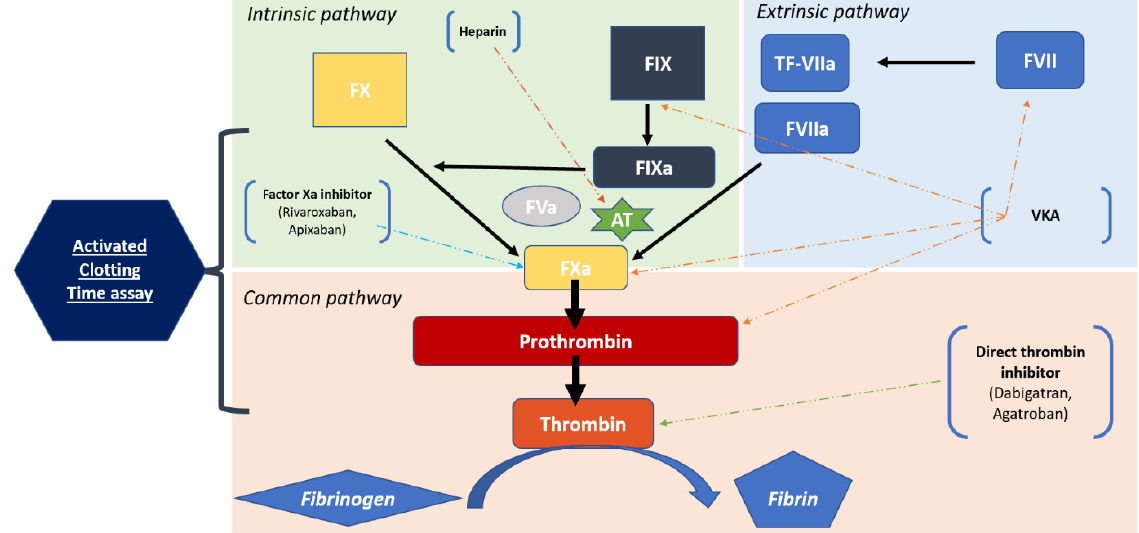
Figure 4. Coagulation process. AT = Anti-thrombin, TF = Tissue Factor.